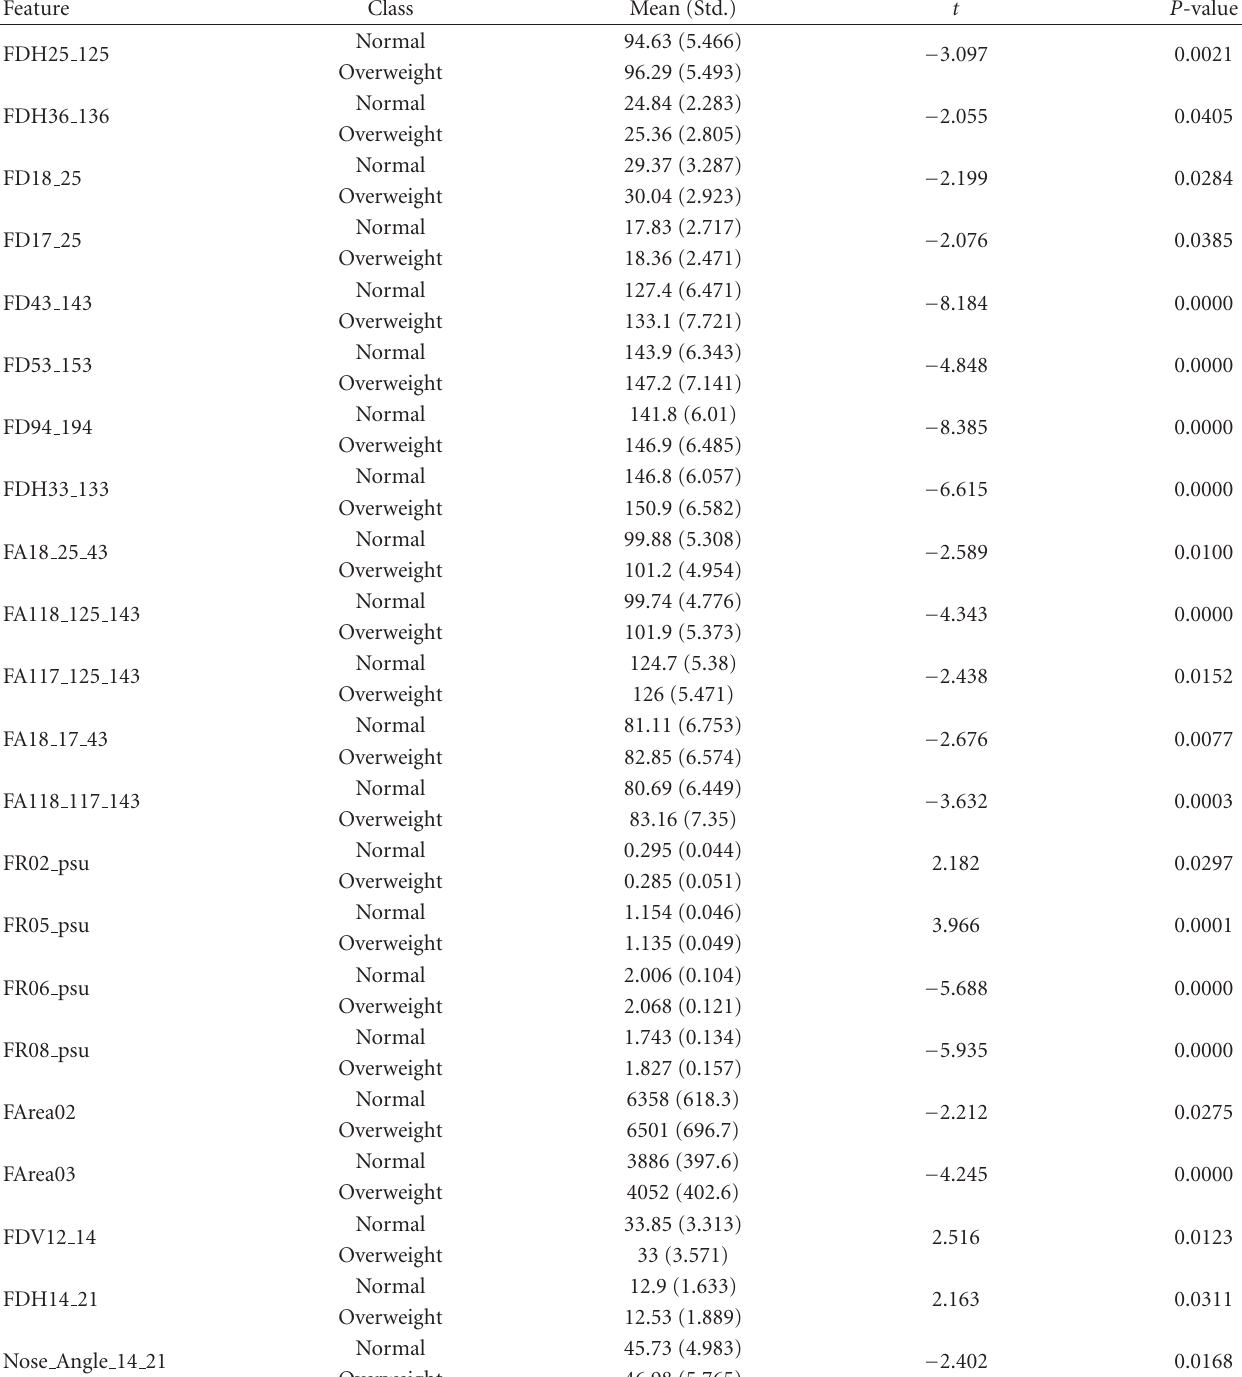
Table 6: Statistical analysis of female: 41–60 group by an independent two-sample t -test (Std.: standard